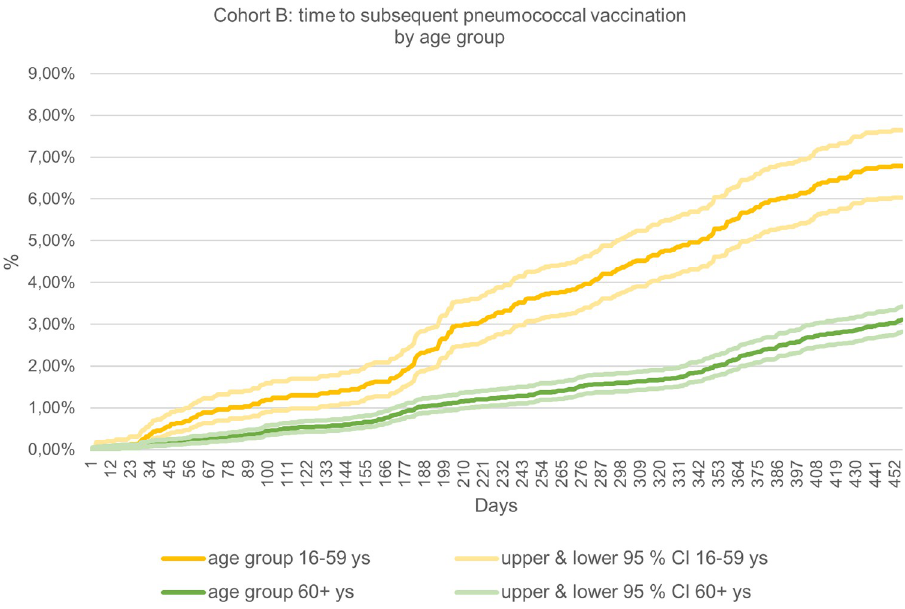
Fig 3. Time (in days) following a first vaccination to a sequential in a 15-month period in cohort B. Patients aged 16–59 (upper and lower 95% CI) compared to patients aged � 60 years (upper and lower 95% CI) patients (see S4 Table in supplemental material for 95%